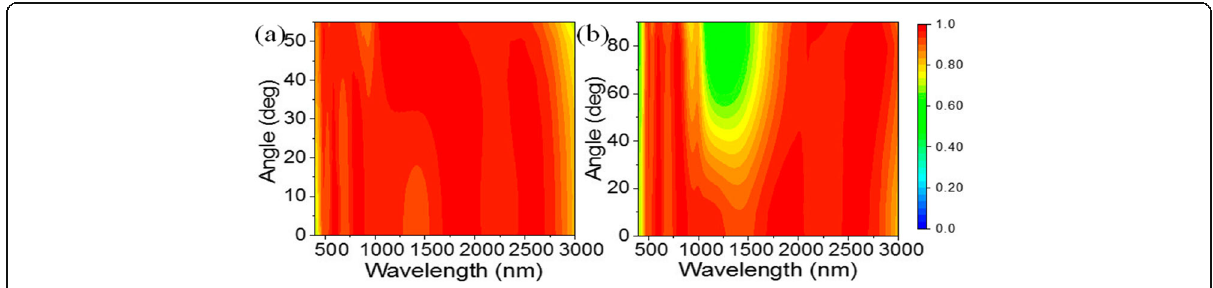
Fig. 3 Absorption mapping of the solar absorber under a tunable incident angle ( a ) and polarization state ( b )